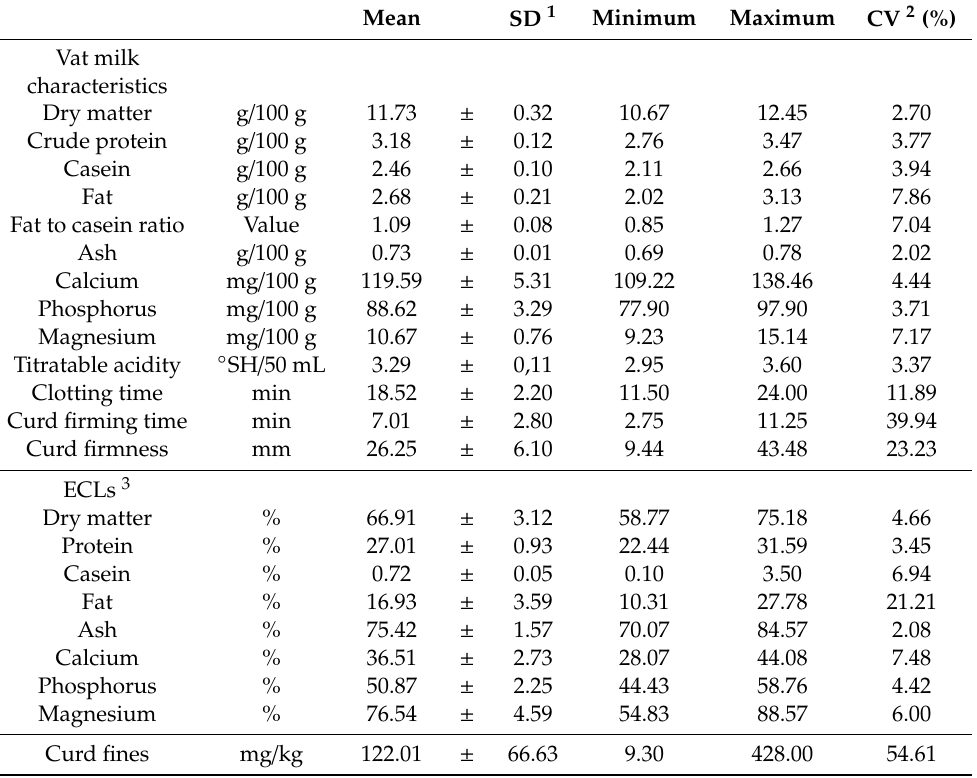
Table 1. Descriptive statistics of vat milk characteristics and estimated cheese-making loss (ECL) values from 288 Parmigiano Reggiano cheese-making